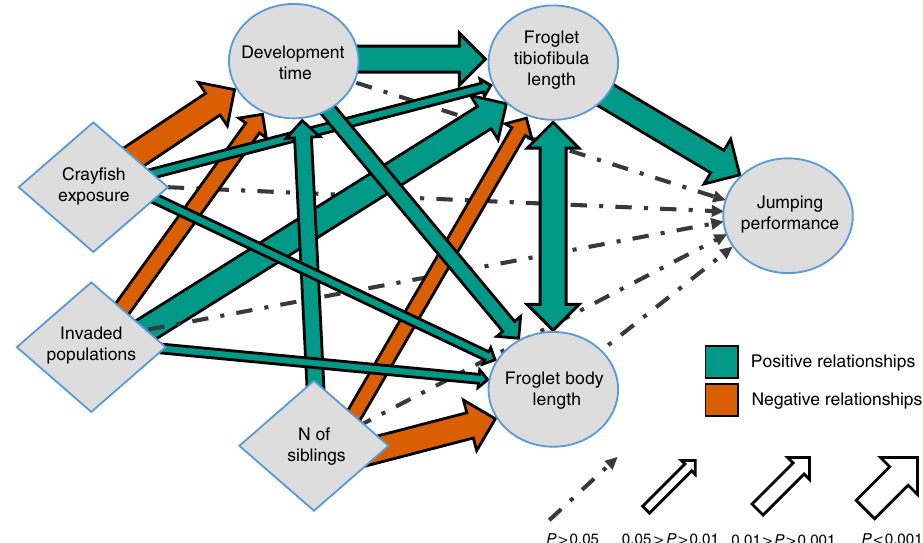
Fig. 4 Structural equation model showing the overall effects of invasive cray fi sh on tadpole development. Diamonds represents fi xed effects, while circles indicate dependent variables. Signi fi cance of relationships is indicated with arrows, and was calculated from SEM using two-sided z statistics. Positive relationships are in green, while negative relationships are in red. The number of individuals per container was included as a covariate, to take into account the effects of density. See Supplementary Table 2 for coef fi cients and exact signi fi cance values of the